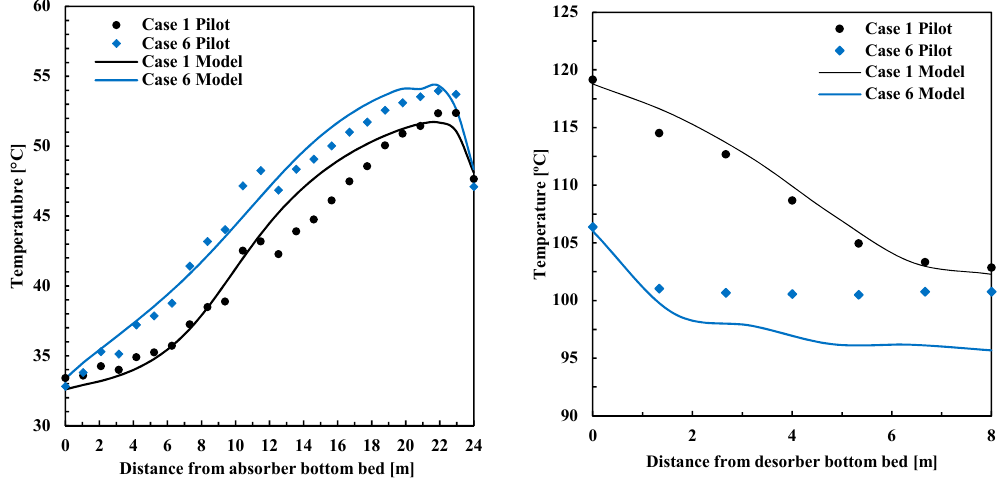
Figure 4. Temperature profiles for absorber column ( left ) and stripper column ( right ) for steady-state cases 1 and 6. In both steady-state operation cases, 24 m of absorber packing were utilized.